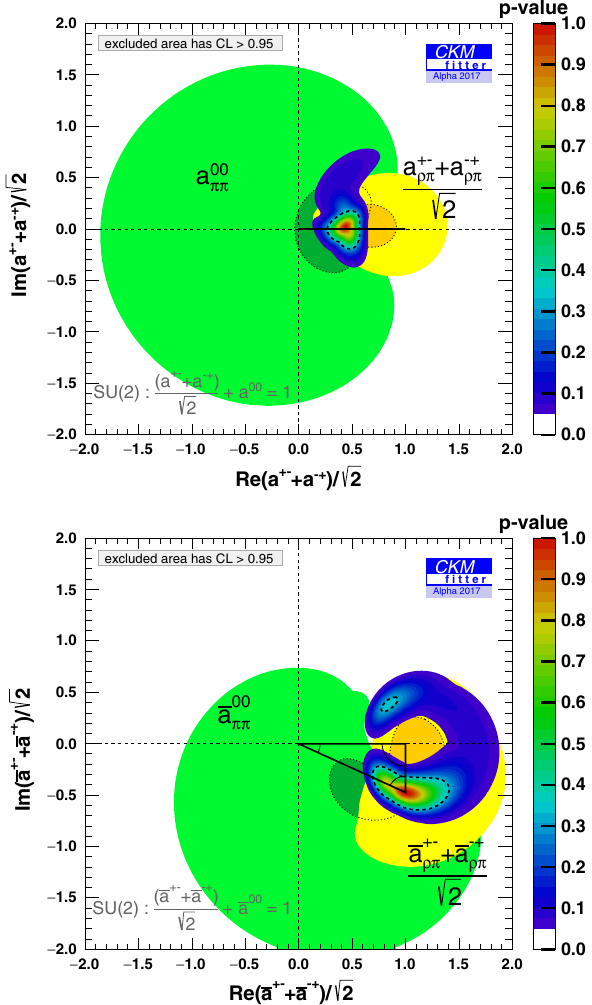
Fig. 8 Constraint on the reduced amplitude ( a +− + a −+ ) = ( A +− + A −+ )/( A + 0 + A 0 + ) in the complex plane for the B 0 → (ρπ) 0 ( top ) and ¯ B 0 → (ρπ) 0 systems ( bottom ). The individual 95% CL constraint from the B 0 ( ¯ B 0 ) → ρ ± π ∓ observables and from the B 0 ( ¯ B 0 ) → ρ 0 π 0 observables are indicated by the yellow and green areas , respectively, whose non-trivial shapes are due to the correlations between the two modes.Thecorrespondingisospintriangularrelations a 00 + a +− / 1 (and CP conjugate) are represented by the black line